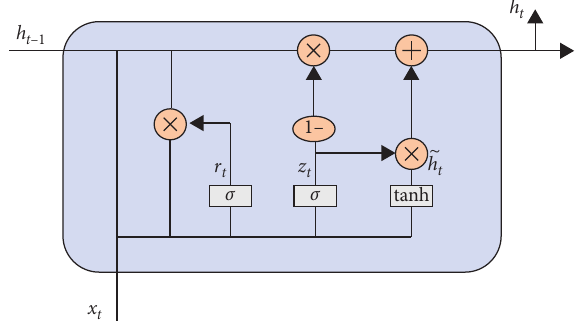
Figure 2: Representation of GRU structure